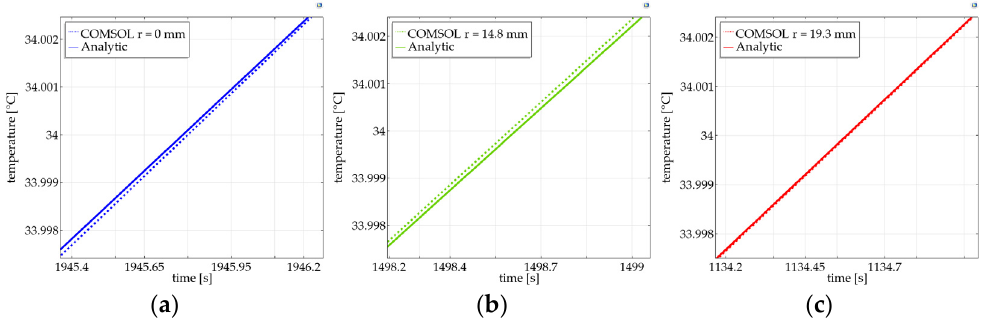
Figure 11. Comparison of numerical results [12] for ( a ) r = 0 mm; ( b ) r = 14.8 mm; and ( c ) r = 19.3 mm with the analytical approximation